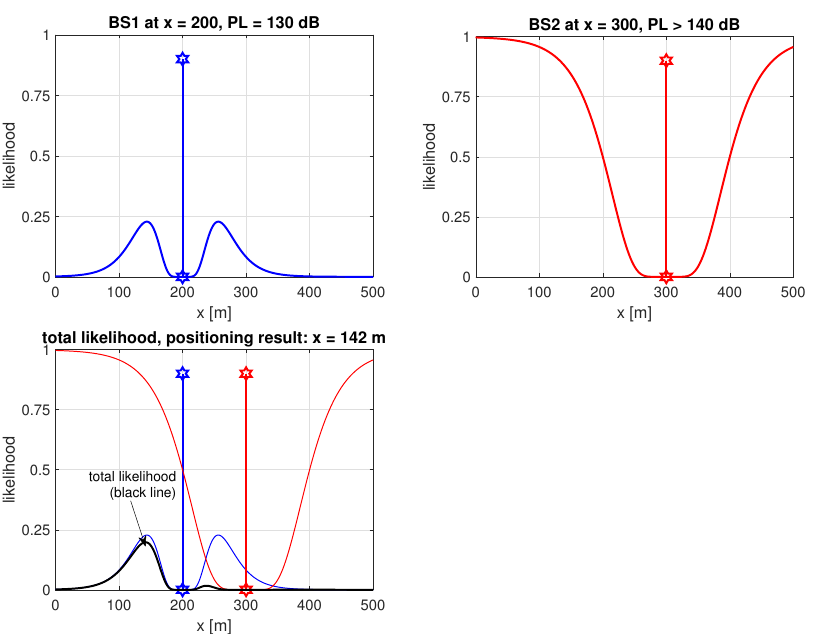
Figure 1. Likelihood function illustration example in 1D: measured path loss (PL) of 130 dB to BS1, censored PL > 140 dB to BS2, and the combined likelihood function. Note that one measured and one censored PL are sufficient to get a unique positioning solution and the same is true in 2D and